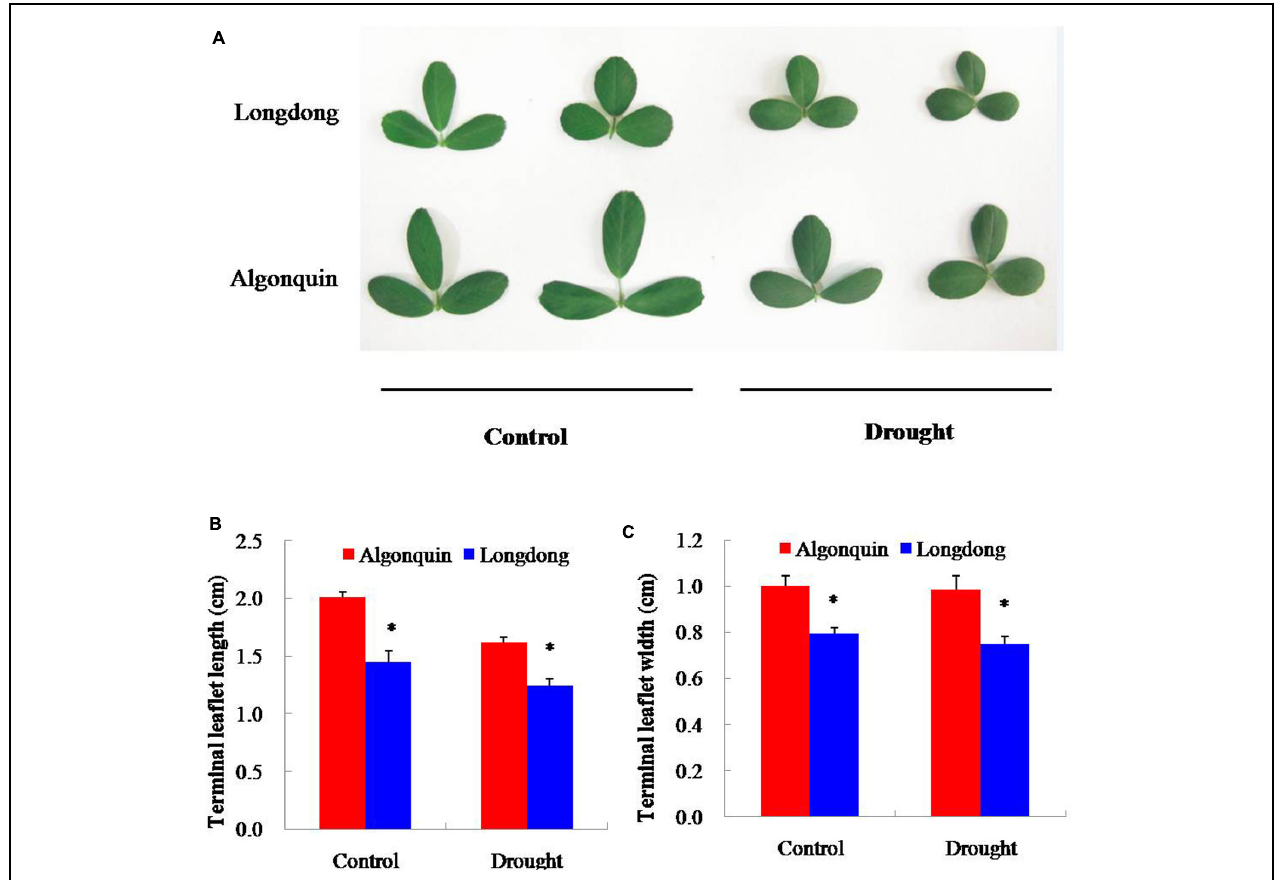
FIGURE 3 | Effect of drought stress on leaf size of two alfalfa varieties. (A) The same part leaves of plant were collected from control and stress conditions after drought treatment 12 days. (B,C) Terminal leaflet length and width of two alfalfa varieties under control and drought conditions ( n = 8). The results shown are means ± SE. Asterisk symbols indicate significant differences at P < 0.05 (Student’s t